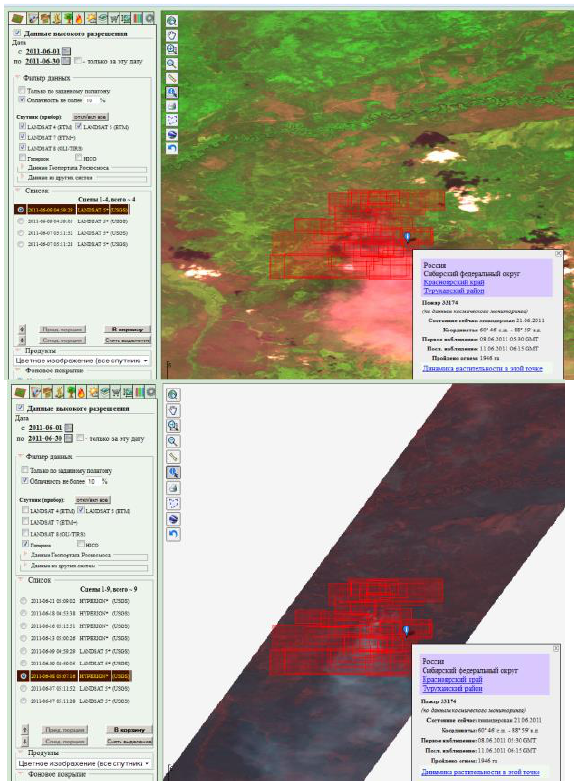
Figure 6. GeoUI equipped with hyperspectral analytic tools: upper image - Landsat -5 (Landsat-4 and -5, 2008) 09.06.2011, lower image - Hyperion (Sensors - Hyperion, 2011) 08.06.2011.